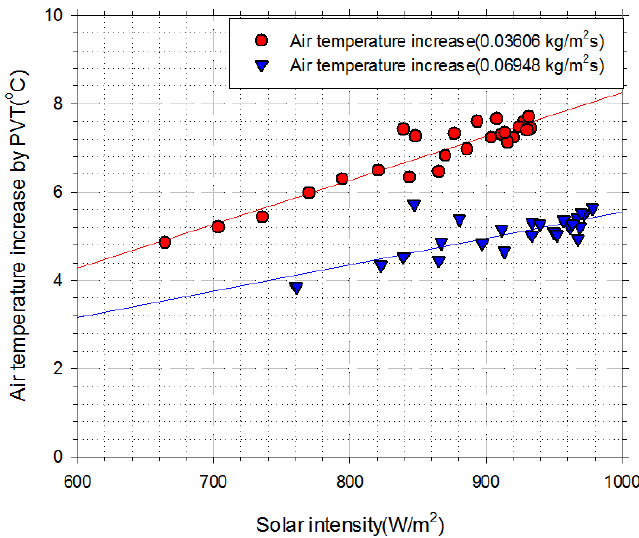
Figure 8. Air temperature increase by PVT air collector with solar intensity.